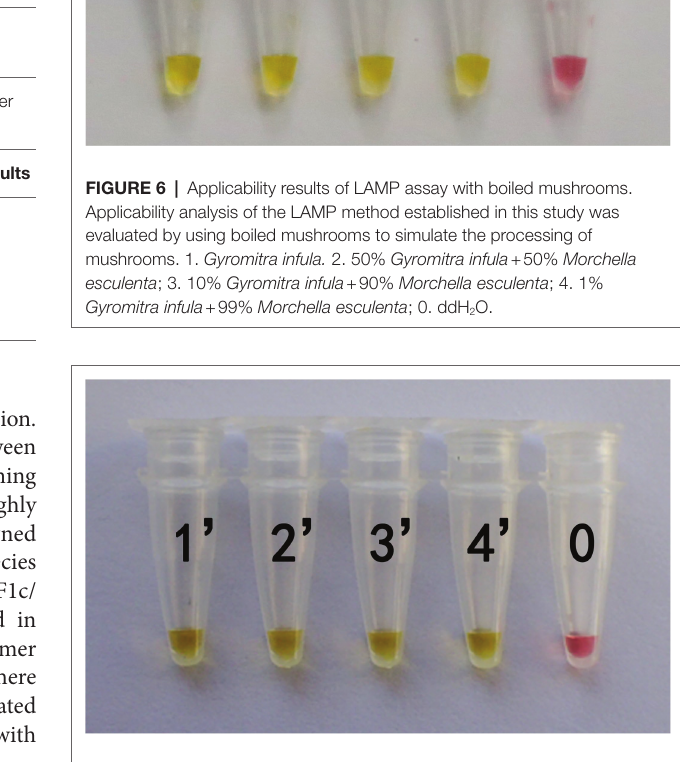
FIGURE 7 | Applicability results of LAMP assay with digested mushrooms after boiled. Applicability analysis of the LAMP method established in this study was evaluated by using digested mushrooms after boiled to simulate the digestion of mushrooms. 1 ' . Gyromitra infula. 2 ' . 50% Gyromitra infula + 50% Morchella esculenta ; 3 ' . 10% Gyromitra infula + 90% Morchella esculenta ; 4 ' . 1% Gyromitra infula + 99% Morchella esculenta ; 0. ddH 2